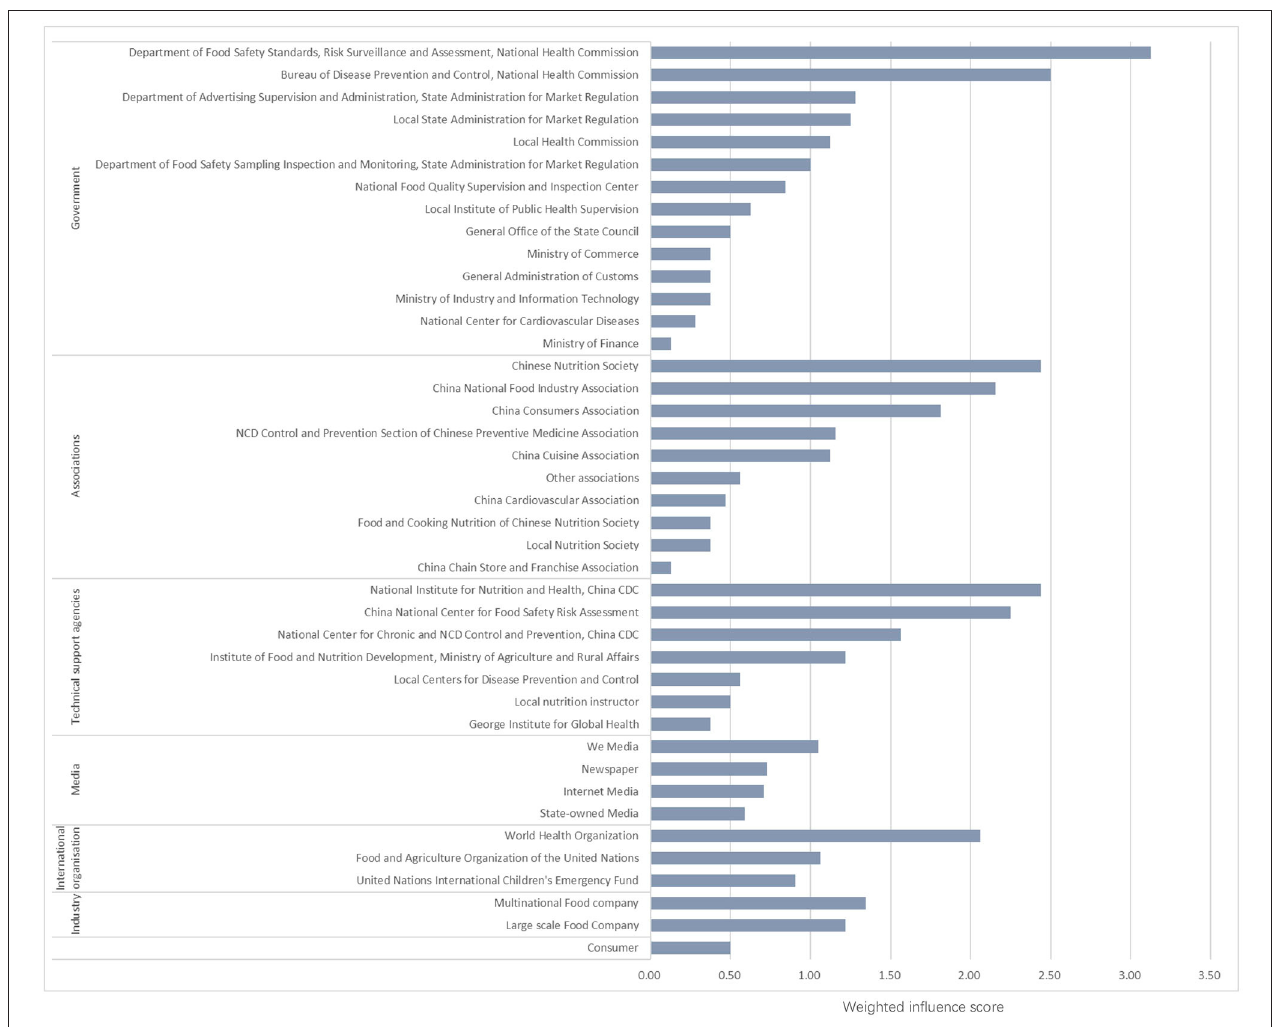
FIGURE 1 | Relative influence of